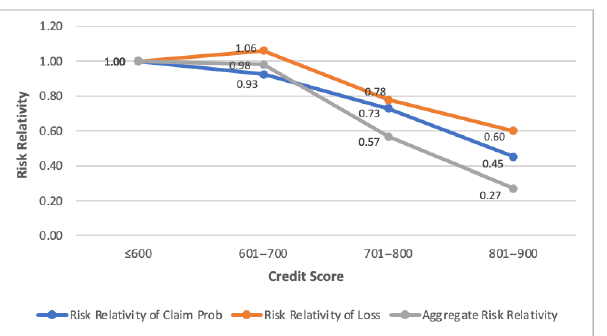
Figure 17. Risk relativities by grouped Credit Scores based on loss severity, frequency, and loss cost (aggregate risk), respectively.